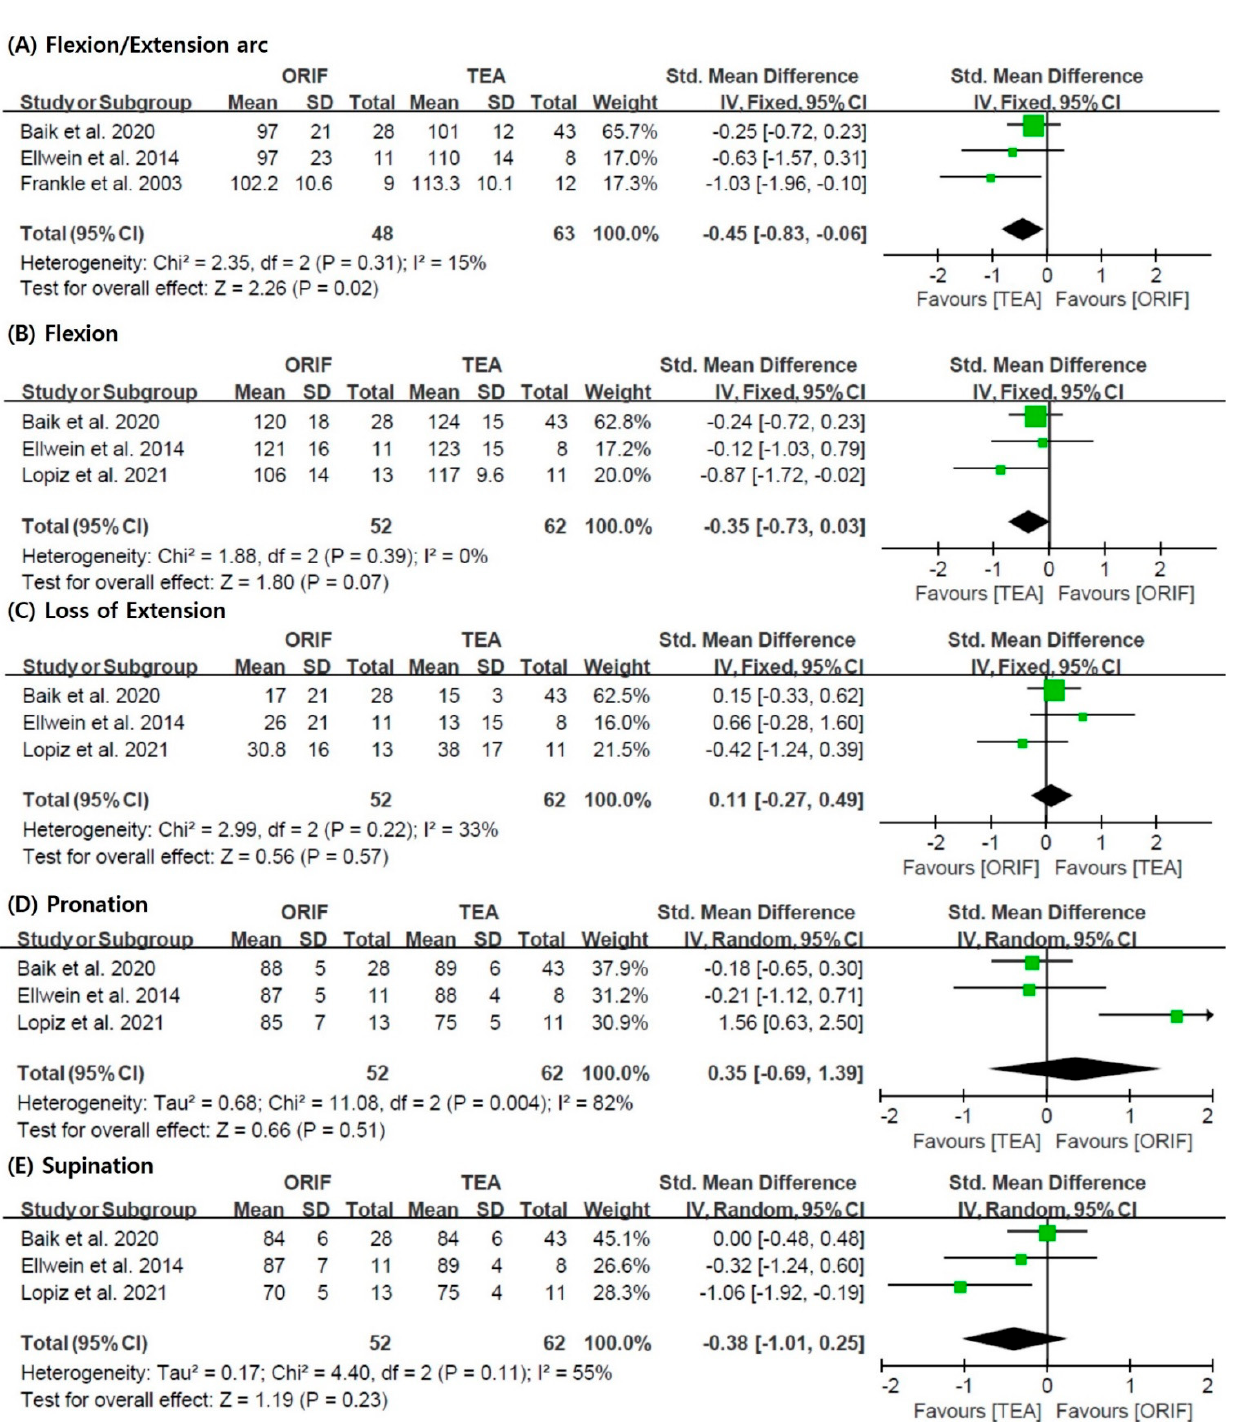
Figure 3. Results of the meta-analysis with respect to the range of motions: ( A ) flexion/extension arc, ( B ) flexion, ( C ) loss of extension, ( D ) pronation, and ( E ) supination [5,21,24,27]. ORIF: open reduction and internal fixation; TEA: total elbow arthroplasty; SD: standard deviation.